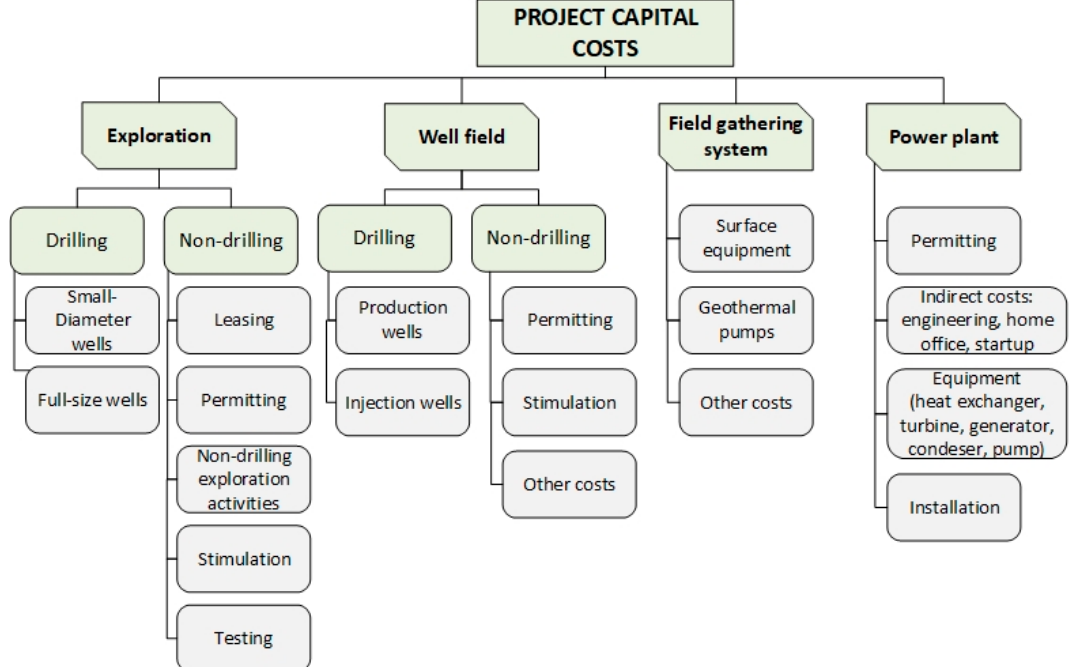
Figure 2. Capital costs included in Decision-Making Support Tool for Optimal Usage of Geothermal Energy (DMS-TOUGE) determination of a system levelized cost of energy (sLCOE).